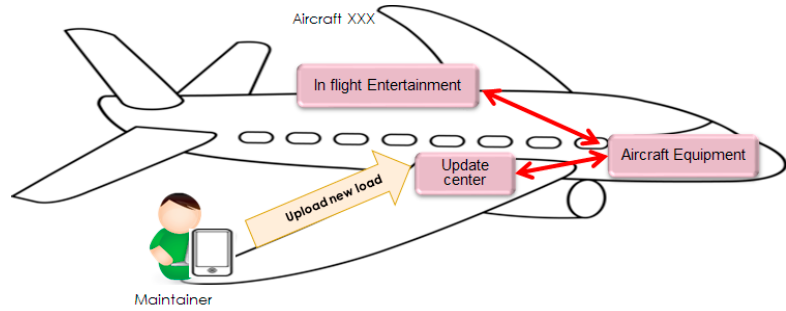
Figure 9. Second scenario.